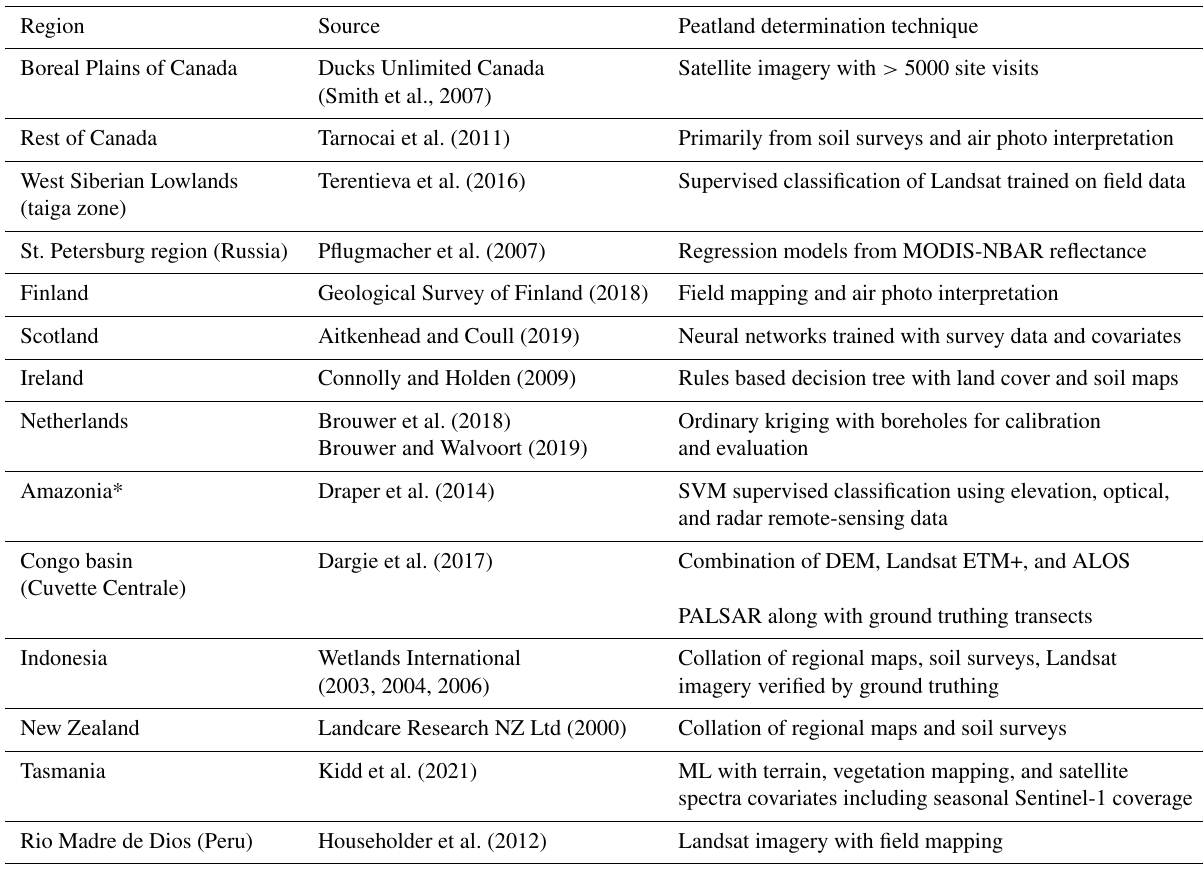
Table 2. Training data (regional peatland mapping products) for the machine learning model.